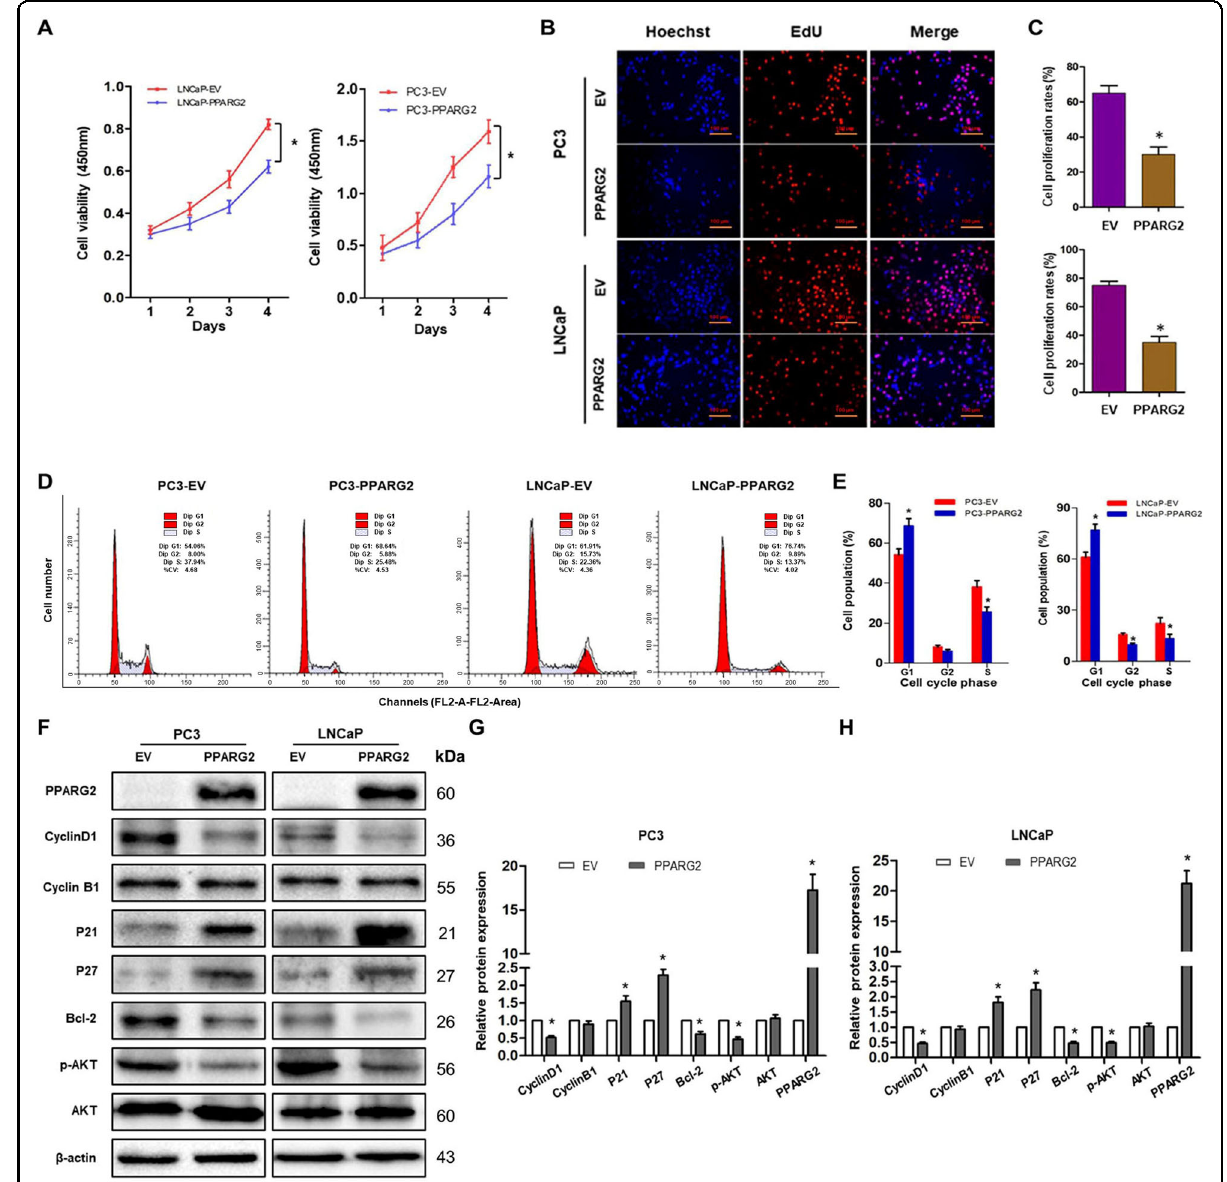
Fig. 3 PPARG2 suppresses cell proliferation and induces cell cycle arrest of PCA cells in vitro. A CCK-8 assay of the proliferation rates of recombinant PCA cell lines transfected with EV- and PPARG2-overexpression lentivirus vectors, respectively. * P < 0.01. B , C EDU assays were performed in EV and PPARG2-transfected PCA cells. * P < 0.05 vs. EV group. D , E Cell cycle pro fi les were examined by fl ow cytometry with propidium iodide (PI) staining; cell numbers were counted according to DNA content of G1, S, and G2 phases. * P < 0.05 vs. EV group. F – H Western blot analysis of cyclinD1, cyclinB1, p21 Cip1 and p27 Kip1 , Bcl-2, p-AKT, and AKT protein expressions in indicated cells. * P < 0.05 vs. EV